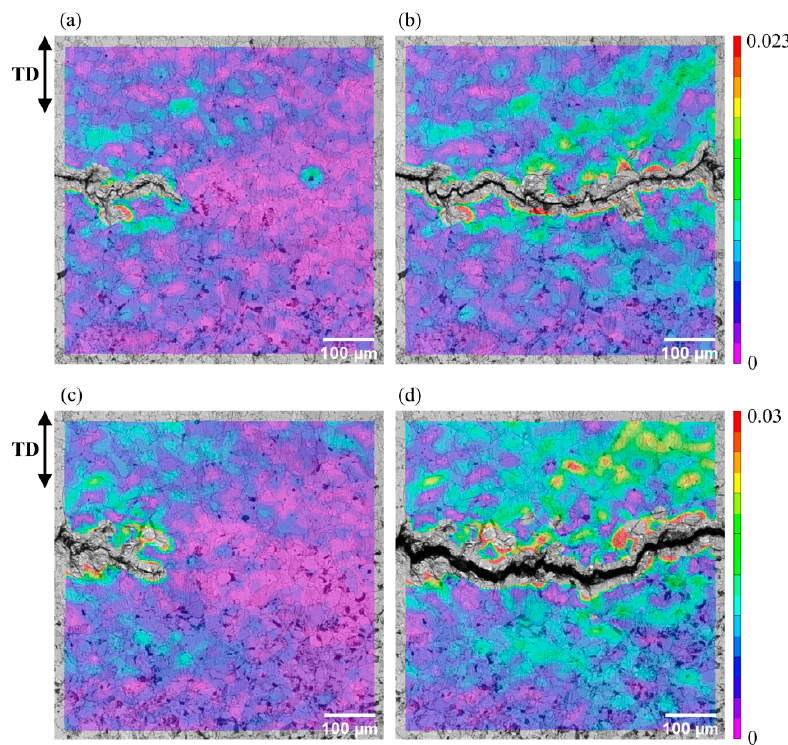
Figure 13. von Mises strain fields of the TD1 specimen under a20× objective lens: ( a ) a = 1.25 mm, N = 55,000 cycles; ( b ) a = 1.75 mm, N = 75,000 cycles; ( c ) a = 1.75 mm, N = 75,000 cycles, crack tip region; ( d ) a = 2.80 mm, N = 85,000 cycles.